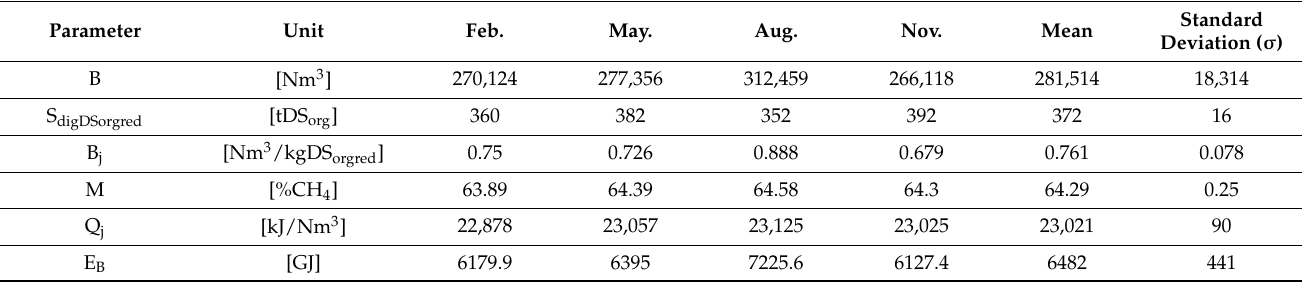
Table 2. Basic biogas data calculated from Sections 2.6 and 2.7–biogas production (B), amount of reduced organic dry matter after THP and AD (S digDSorgred ), biogas production rate (B j ), average methane content (M), biogas calorific value (Q j ) and energy potential of biogas (E B